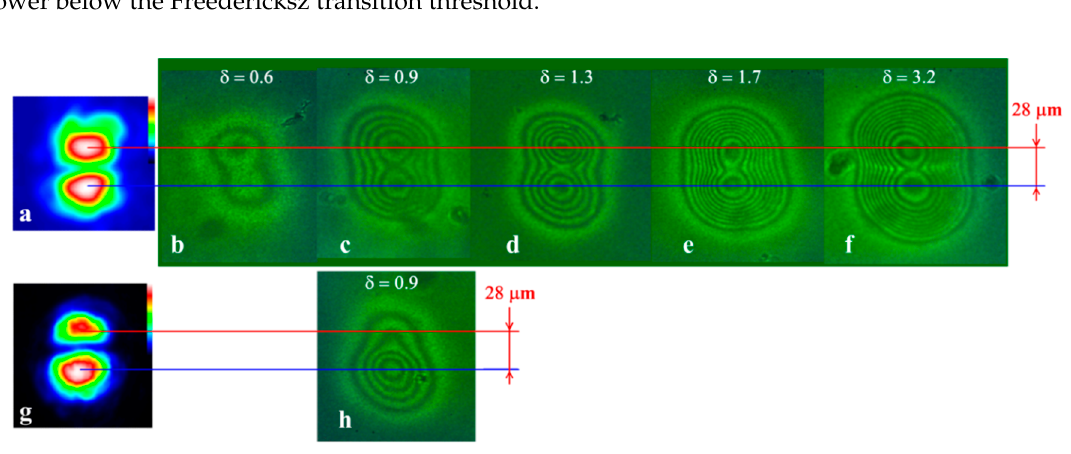
Figure 8. The phase shift reconstructed from the microphotographs shown in Figure 7. Lines are an eye-guide connecting the experimental points. As for the normal light incidence, with a significant increase in the size of the beam, the phase image shows not only the positions of the peaks but also the shape of the beam (Figure 5e2). This mode of the light effect can be considered in the local approximation without taking into account transverse elastic forces. Summarizing the above results we could conclude that the phase structures recorded under action of normally and obliquely incident light beams with over-threshold power are quite similar. At the same time, the oblique incidence allows one to record developed phase structures ( |𝛿𝑆|~10 ) at light power below the Fréedericksz transition threshold. The longer recording times for the normal light beam incidence are related to the fact that at this light–NLCP interaction geometry the optical torque for the unperturbed director field is zero. The director field transformation starts from the growth of a suitable fluctuation, whose occurrence can take some time. 3.3. Microlens Recording Various methods of producing lenses were reported for low molecular weight NLCs (including creation of polymer networks) [18–25,31,32] and amorphous polymers [26]. In this study, we applied the optical recording of the phase structures in the NLCP for the formation of negative and positive lenses. In the studied case of the negative nonlinearity, the director rotated normally to the light field E , decreasing the refractive index proportionally to the intensity of the light. Recording the phase structure with a relatively wide Gaussian beam (beam diameter 2 w = 200 μ m, δ = 4.3) allowed us to form a phase profile, which acts as a defocusing lens for the beam, passing through its central part -80 -60 -40 -20